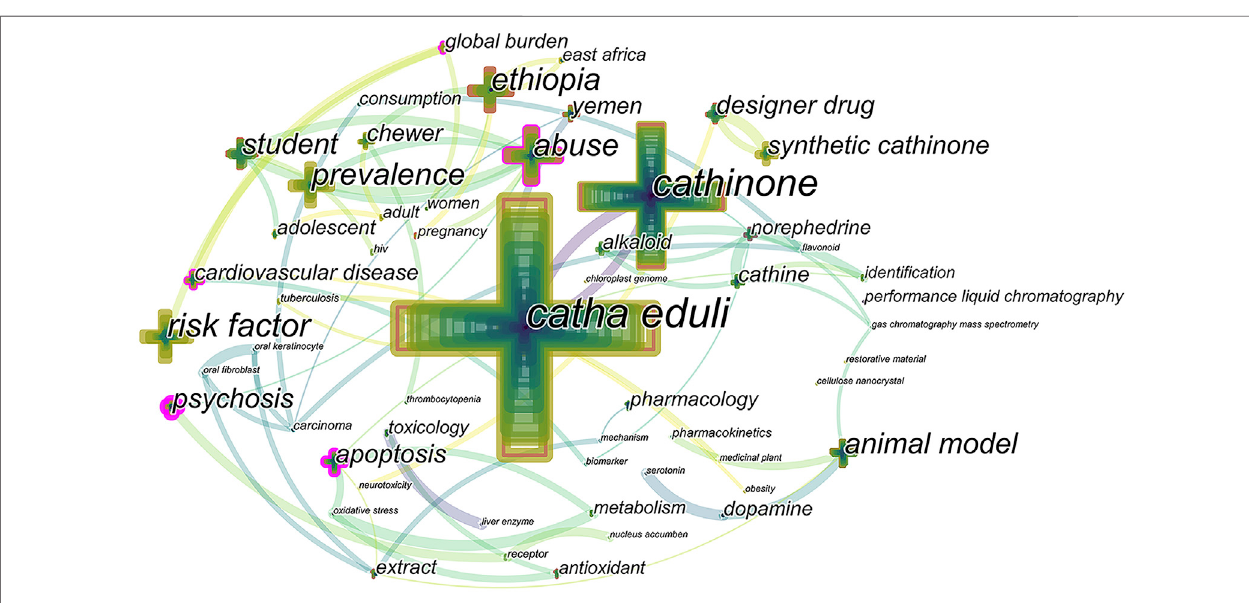
FIGURE 4 | Network of keywords co-occurrence. The cross size and the link each illustrated the frequency and relevance of keywords.